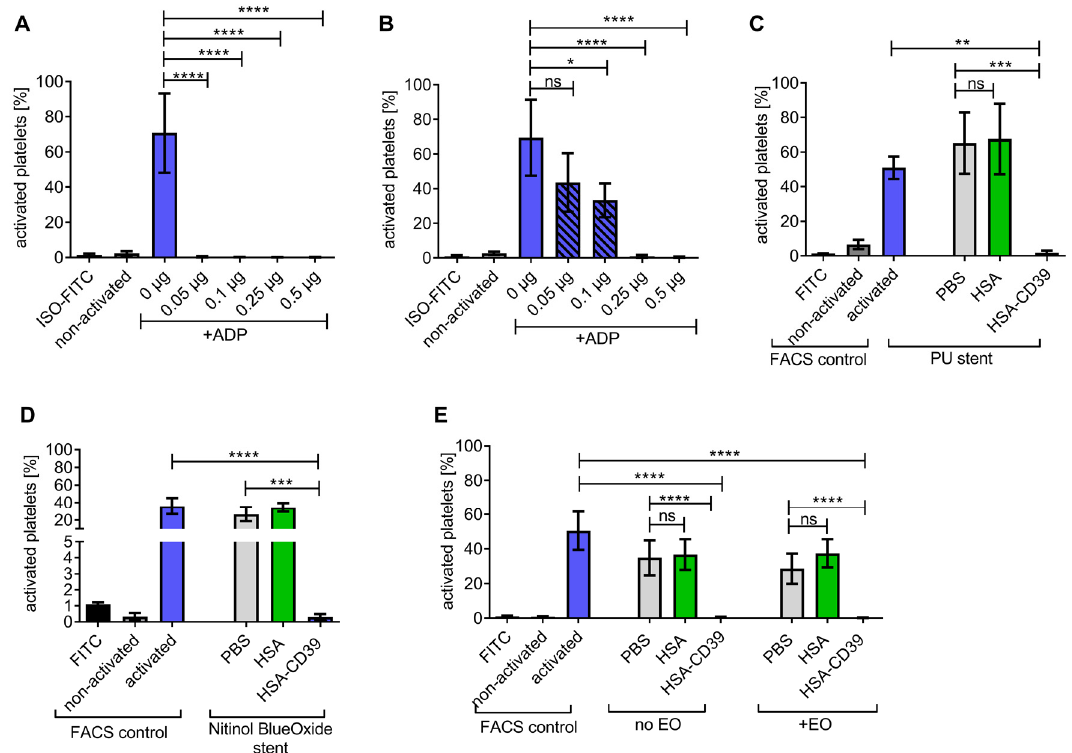
Figure 5. HSA-CD39 can be coated onto stainless steel, polyurethane stents and nitinol BlueOxide stents even after sterilisation with EO without reducing its functionality. ( A ) Significant reductions in platelet activation can be seen with different concentrations of HSA-CD39-coated stainless-steel plates without washing. ( B ) HSA-CD39 coated onto stainless-steel plates displays a reduced but still significant reduction in platelet activation after washing with PBS before analysis in flow cytometry. Bar graphs depict % of activated platelets. ( C ) Dried and coated HSA-CD39 on polyurethane stents as well as nitinol BlueOxide stents. ( D ) Shows effective prevention of platelet activation as analysed via flow cytometry. ( E ) HSA-CD39 and HSA for comparison, coated on Ti plates, shown to be still functional in hydrolysing ADP after EO sterilisation. The different groups were compared using repeated-measures ANOVA and Bonferroni post hoc tests. ns = non-significant. Values of at least 3 independent experiments are depicted (% activated platelets ± SD, * p < 0.05, ** p < 0.01, *** p < 0.001 **** p <